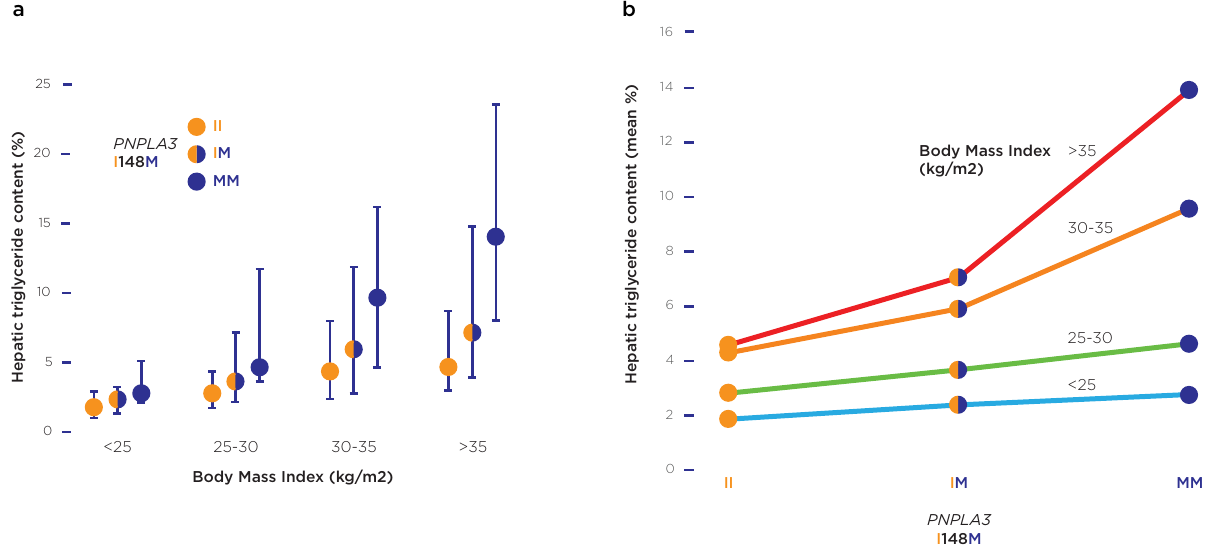
Fig 4. ( a ) The interaction of genotype and body mass index to cause MAFLD (quantified by hepatic triglyceride content, y axis) is vividly revealed using data from the Dallas Heart Study [116]. ( b ) Replotting the same data using the format of Fig 2 to show the combined genetic and environmental influences in MAFLD. The WebPlotDigitizer tool (https://automeris.io/WebPlotDigitizer/) was used to extract the raw data from the source image in the published work [115], in the